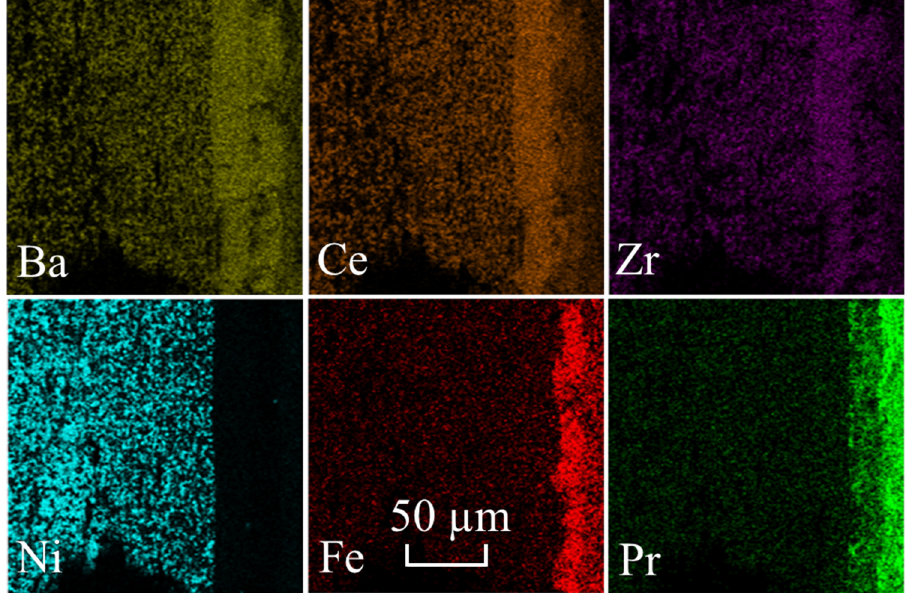
Figure 9. Element distribution maps for the PCFC with the BCZYF0.6 electrode following PrO x electroactivation.